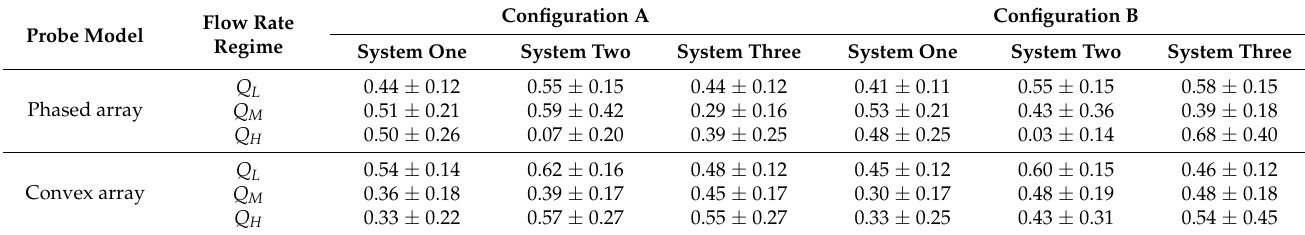
Table 11. Average Maximum Velocity Sensitivity parameter results (mean ± SD).